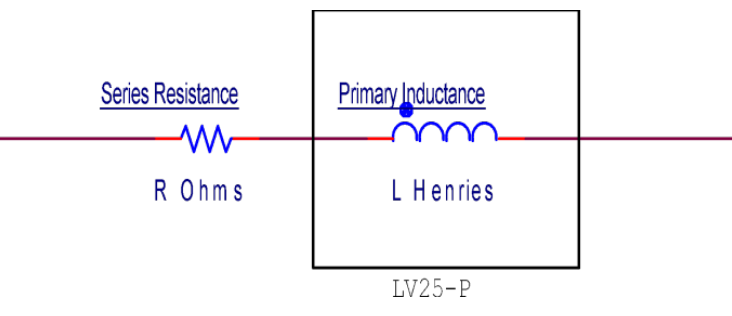
Figure 6. LEM25-P-equivalent circuit.